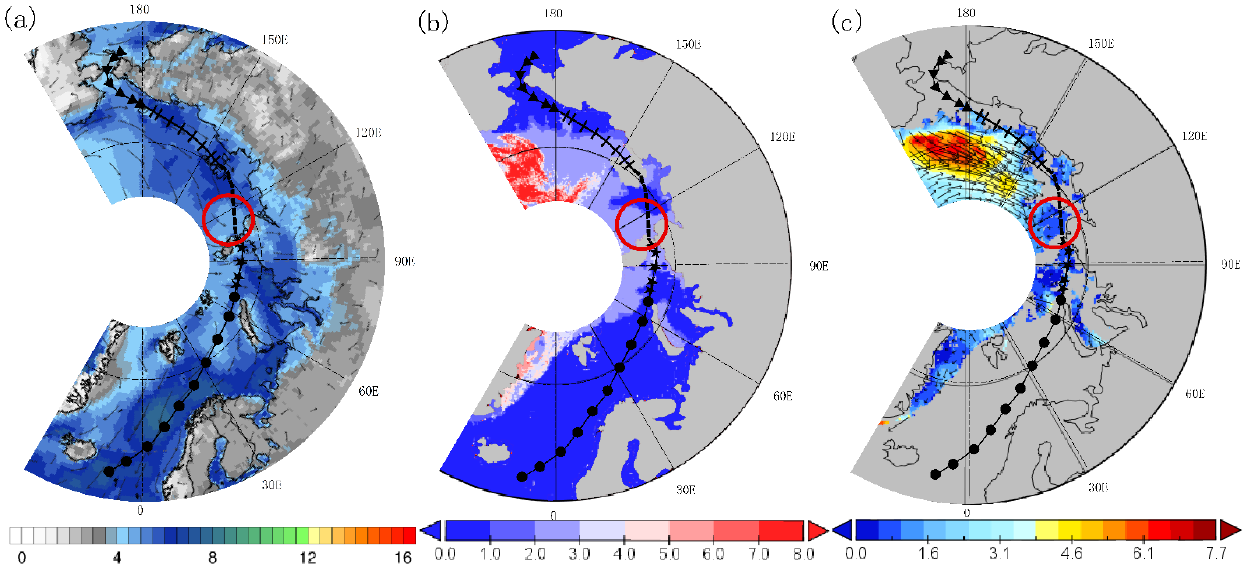
Figure 13. The average wind field ( a ), sea ice age ( b ) and sea ice movement ( c ) of the NEP in the Arctic in September 2002. J. Mar. Sci. Eng. 2021 , 9 , x FOR PEER REVIEW